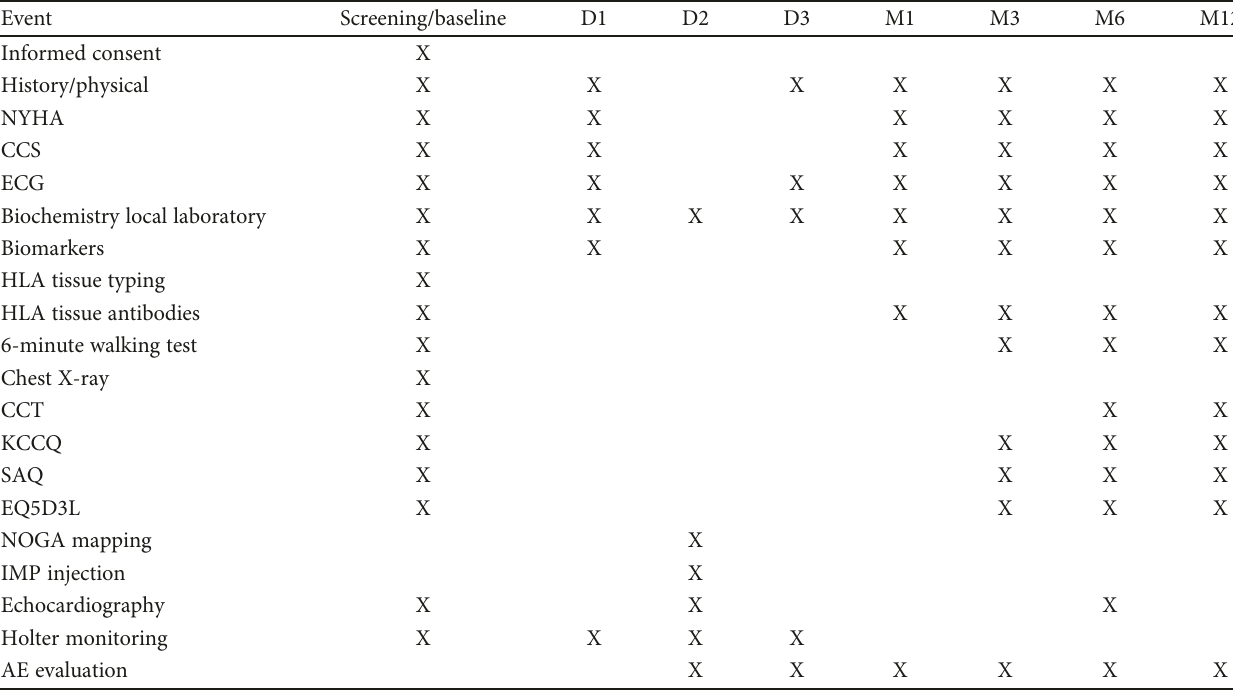
Figure 1: Design of the MSC-HF II trial. CSCC_ASC: cardiology stem cell centre adipose-derived stromal cells. Table 2: MSC-HF II study: summary of